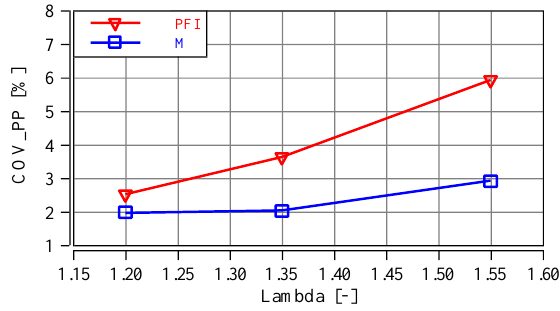
Fig. 8. Effects of injection system on coefficient of variation of peak pressure (PP) for different charge composition